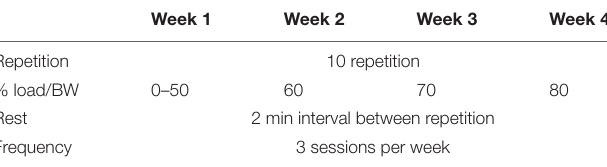
TABLE 1 | Progressive resistance exercise protocol.